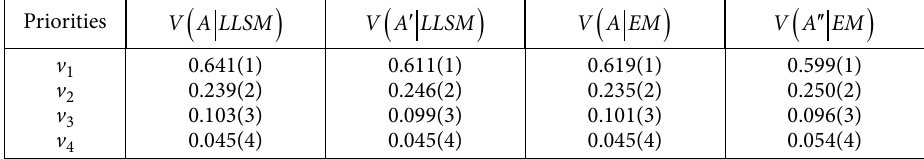
Table 10. The priority vectors and rank orders by LLSM and EM from three PCMs